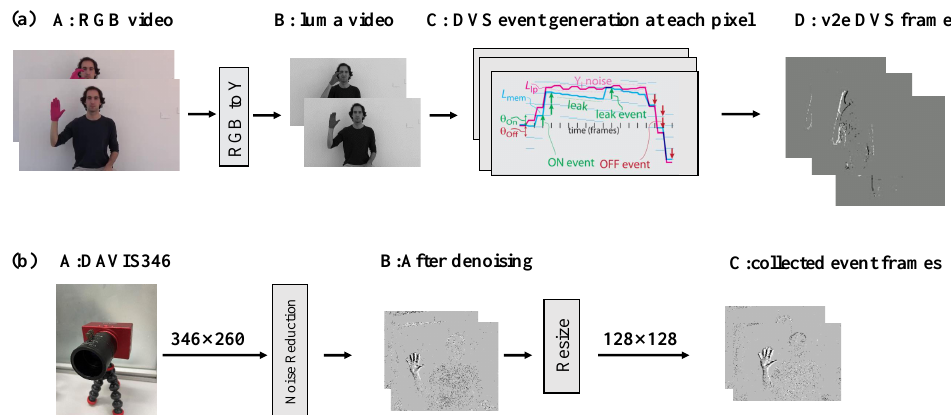
Figure 4. Two datasets processing methods. ( a ): use the v2e method to convert RGB video to event stream data; ( b ): use DAVIS346 to collect sign language event video streams for